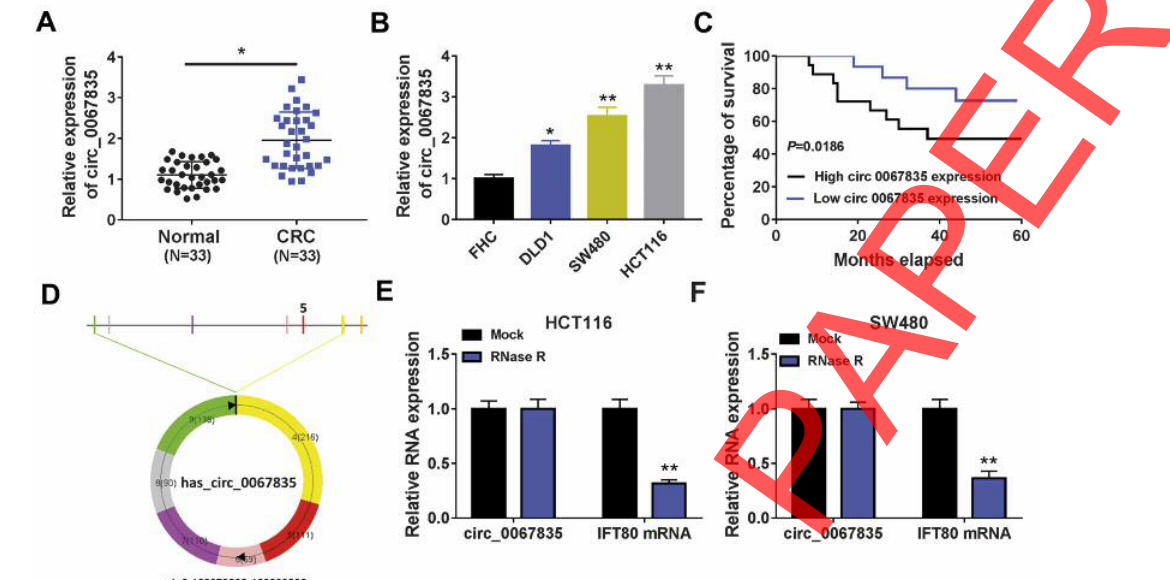
Fig. 1 Higher expression of circ_0067835 in CRC tissues and cells. (A) qRT-PCR assay for the relative expression of circ_0067835 in normal tissues and CRC tissues (n = 33). (B) qRT-PCR assay for the relative expression of circ_0067835 in FHC, DLD1, SW480 and HCT116 cells. (C) Kaplan-Meier analysis for the survival of 33 CRC patients with high or low circ_0067835 expression. (D) Schematic diagram of circ_0067835 circularization by the back-splicing of exons 4-9 of LDB mRNA. (E and F) RNase R assays in both HCT116 and SW480 cell lines. * p < 0.05, ** p <